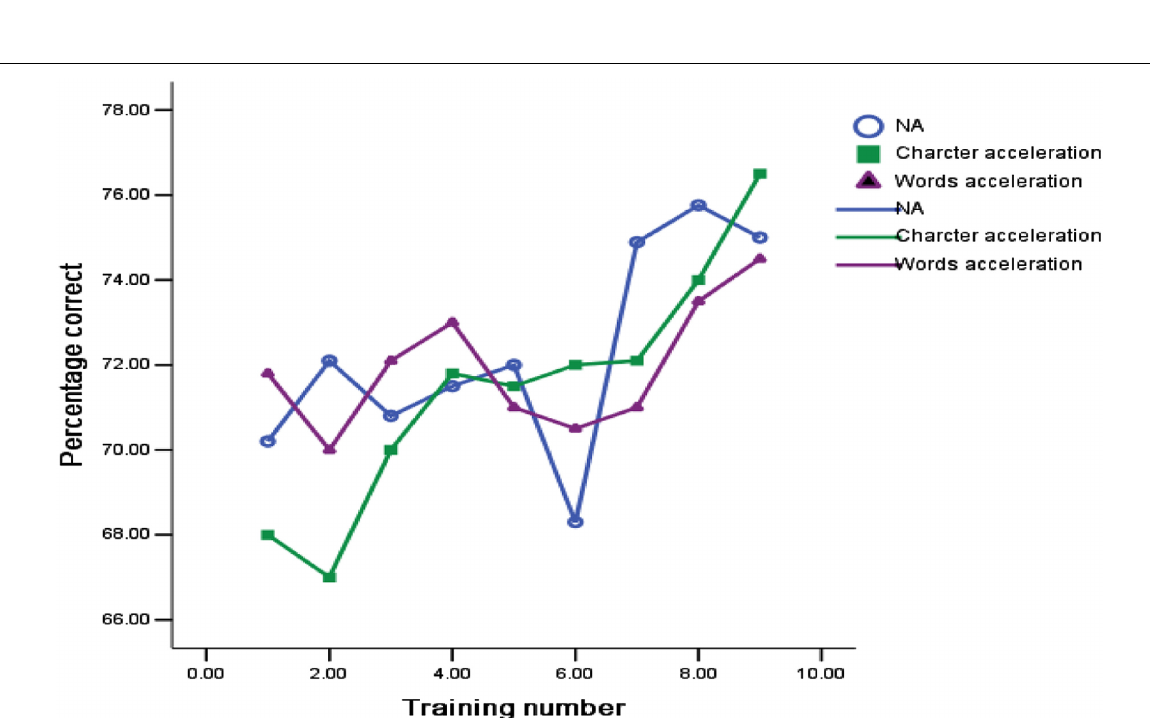
Frontiers in Psychology |